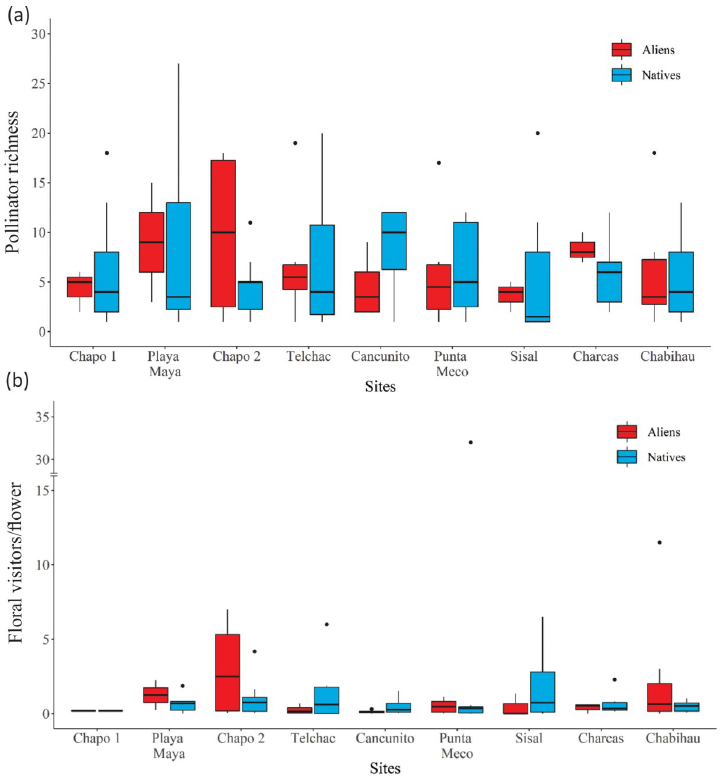
Fig 2. Box-plot for (a) Floral visitors’ richness; and (b) flower visitation rate per plot registered in each study site. Sites are ordered according to increasing proportion of alien flower abundance (see Table